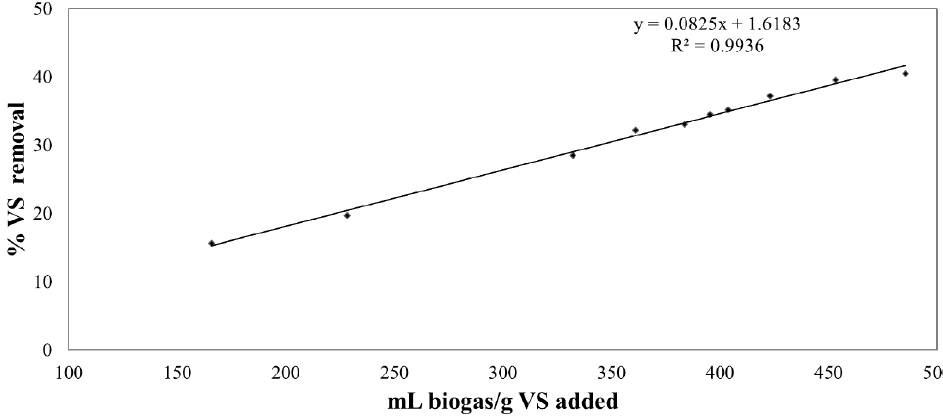
Figure 4. The relationship between biogas yield and volatile solids (VS) removal.